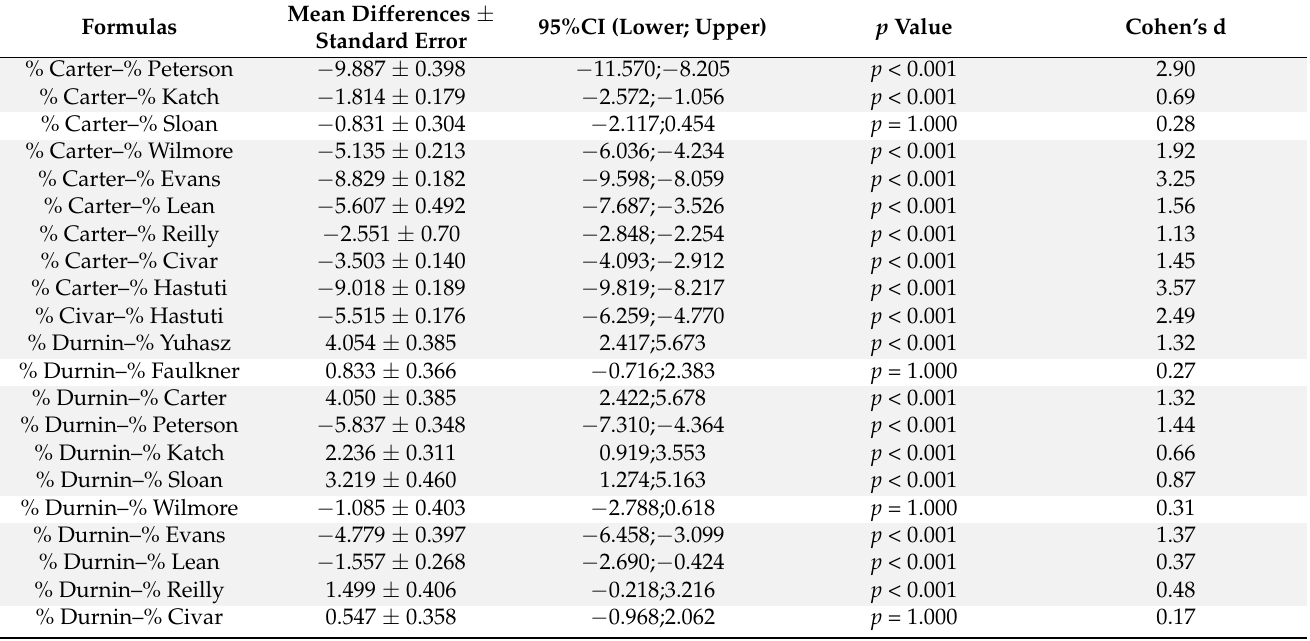
Table 3. Differences between lipid formulas in mean of percentages in